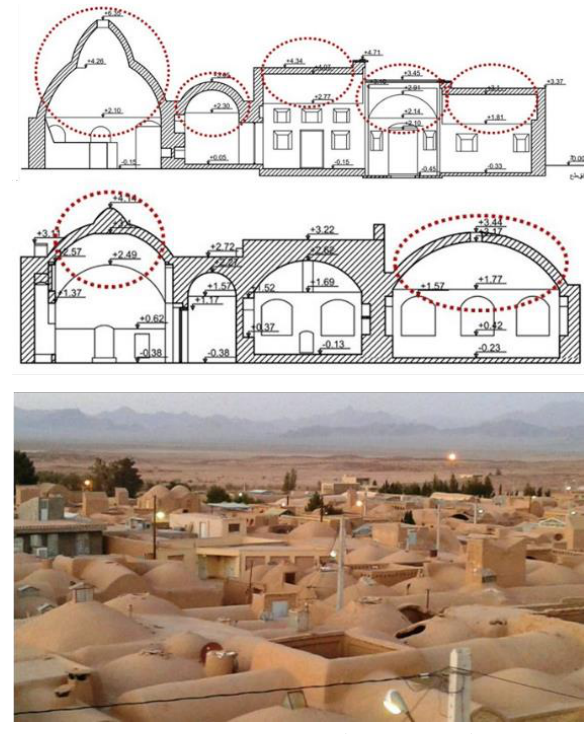
Figure 7. An example of a curved roof in the chahar-sofe